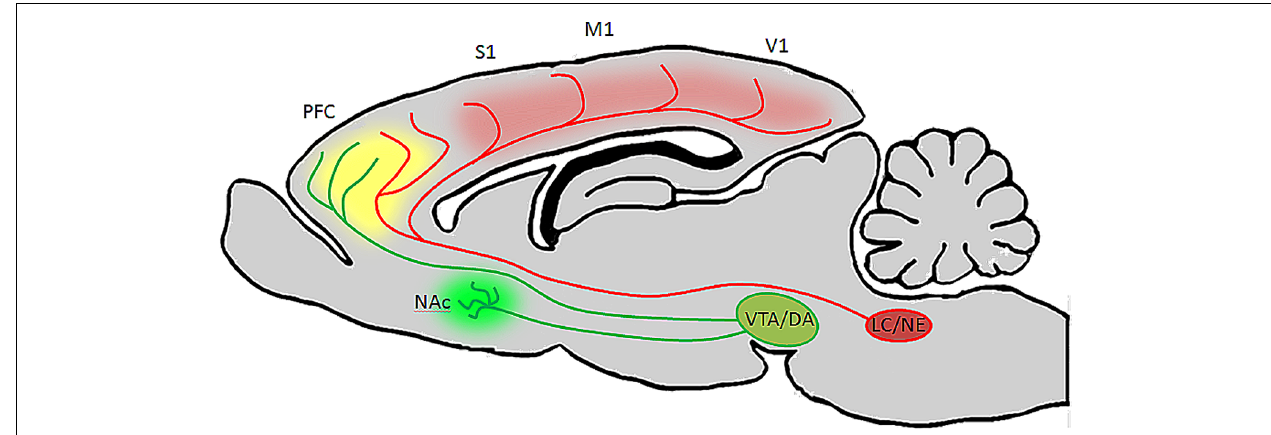
FIGURE 4 |Ventral tegmental area and LC neurons have distinct targets but their efferent fibers converge in PFC. In the rodent brain, LC projects heavily to the entire cortical mantle, including PFC and primary sensory and motor areas, but not to the striatum or NAc (Berridge andWaterhouse, 2003). VTA on the other hand innervates NAc and PFC, but provides only sparse innervations to more posterior cortical areas (Berger etal., 1991).Therefore, during periods of arousal and vigilance, when LC andVTA discharge is